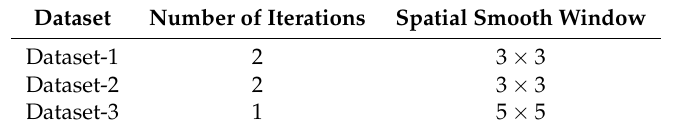
Table 4. Iterations and window size.